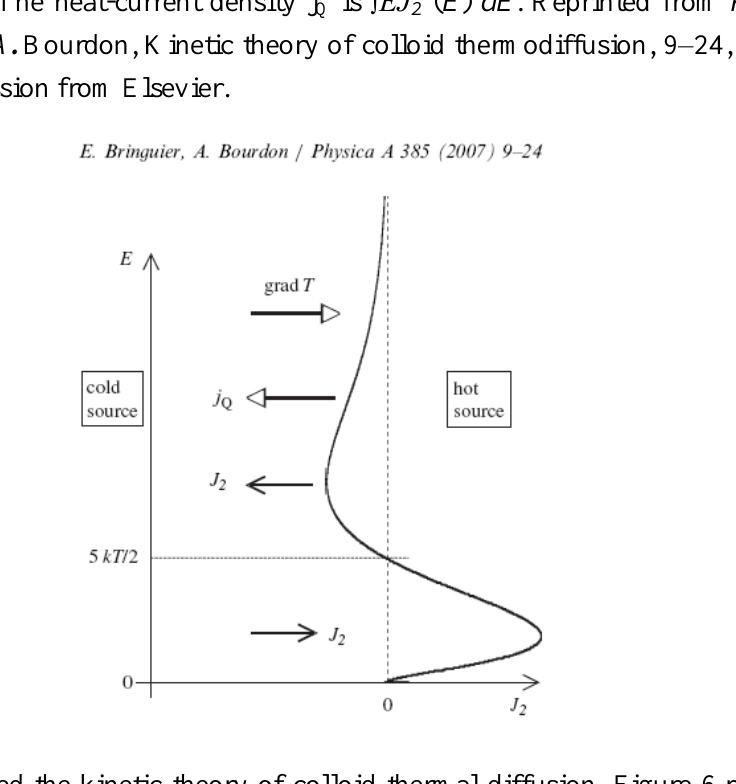
( E ) shows that ‗‗cold‘‘ 2